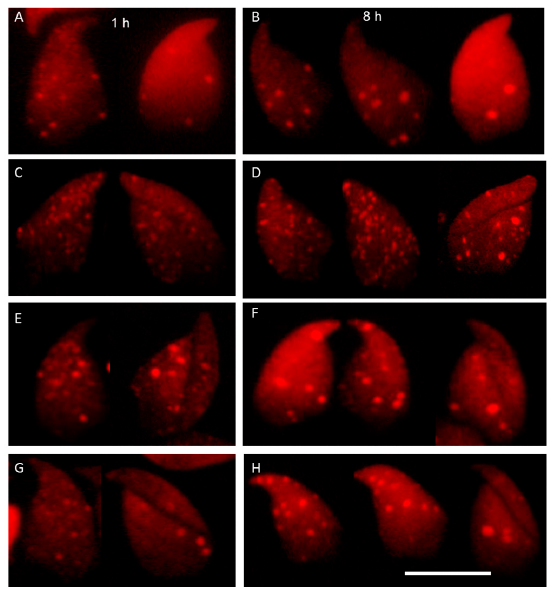
Figure 3. Representative images from irradiated meiotic spreads of pachytene spermatocytes and elongated spermatids stained for γ -H2AX, at 1 h and 8 h after ionized radiation (IR) in wild type ( A , B ); RAD54/RAD54B double knockout mice ( C , D ); SCID mice ( E , F ) and PARP1 inhibitor (DPQ)-treated mice ( G , H ). Scale bars: 10 µm.